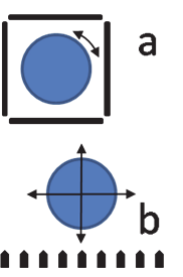
Fig. 8: (a) Rotating fields may induce a torque leading to object rotation in (increasing effective polarizability of object with frequency) or against (decreasing effective polarizability) the direction of field rotation. (b) This torque corresponds to the translational forces in TWDP. Lifting or attracting forces correspond to the DP forces in Figure